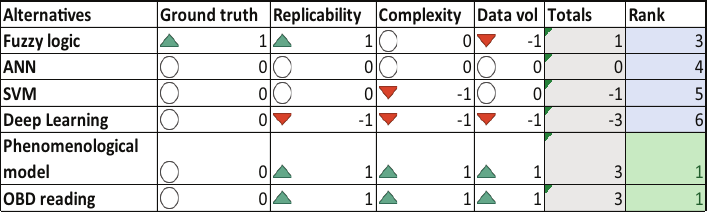
Figure 5. Decision matrix—Energy